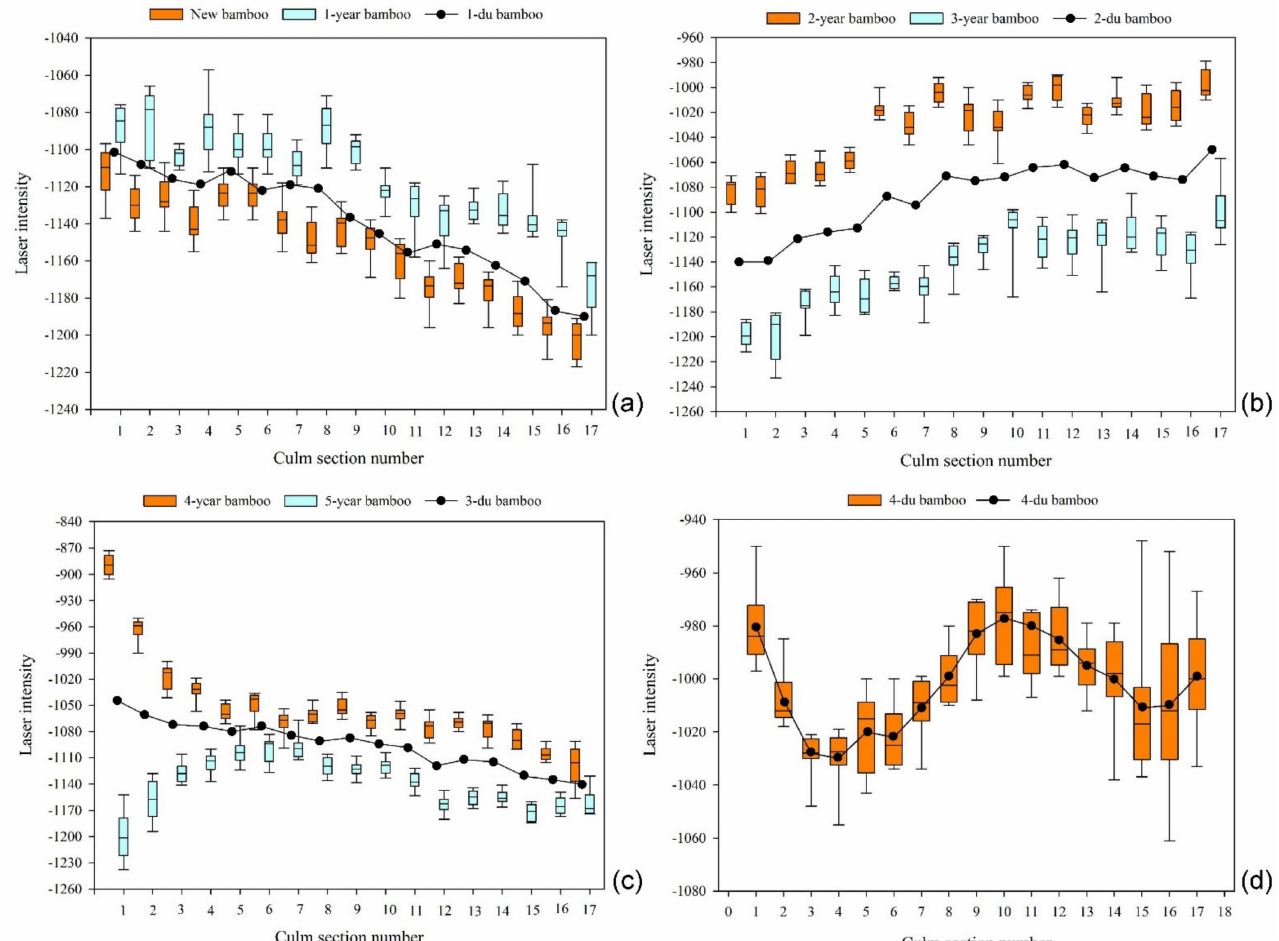
Figure 6. Laser intensity of Moso bamboo plants of different ages. For each du, the intensity value of a single culm section is the mean intensity value of all bamboo plants of the same du. The central lines within each box are the medians. The boxes’ edges represent the upper and lower quantiles.